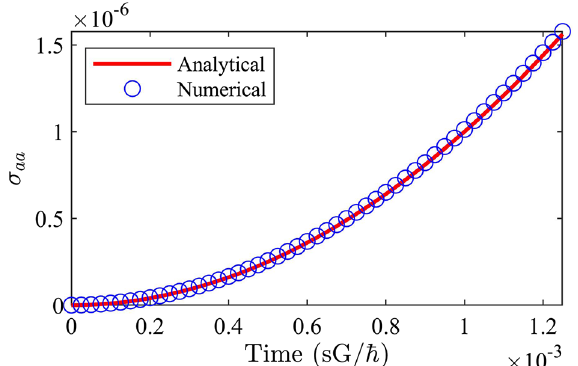
Figure 1. Comparison of a perturbative analytical solution (according to Eq. (27)) and a numerical solution (calculated according to time- and normal-ordered Eqs. (11)–(16)) for the excited vibrational state population ̂𝜎 Δ = 0 aa for small times. Here, the two-photon detuning